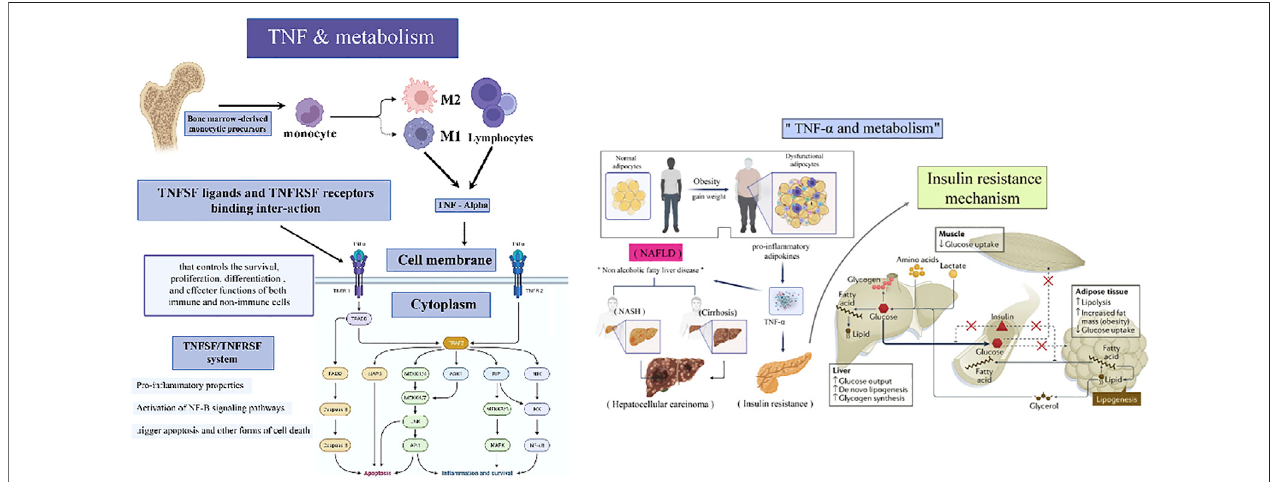
FIGURE 2 | A pictographic representation depicting the roles of TNF and TNFR in metabolism and IR.